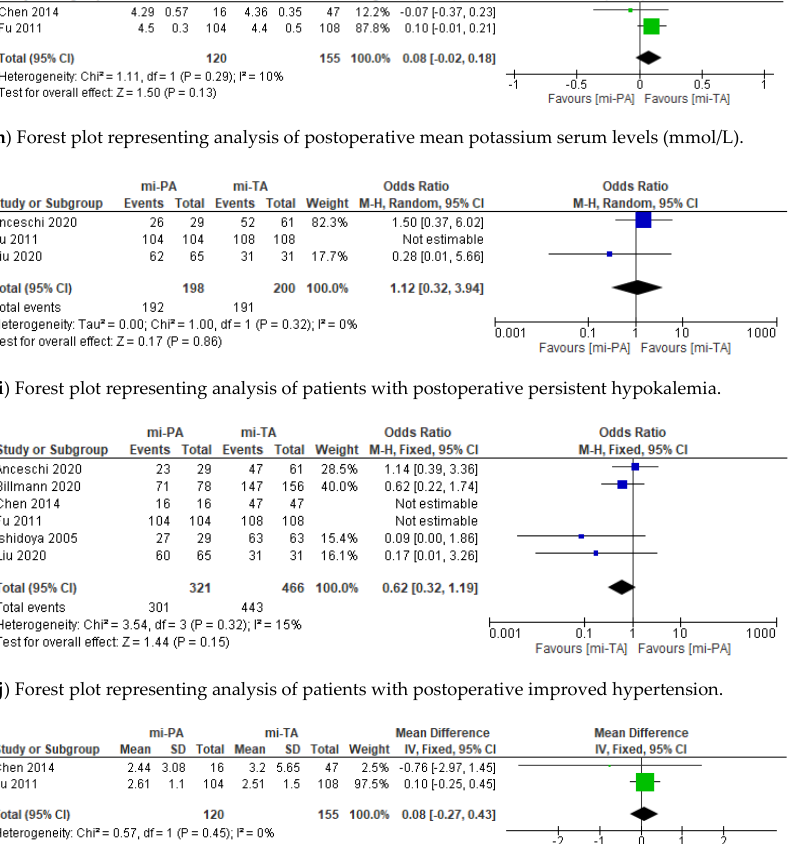
( k ) Forest plot representing analysis of postoperative plasma renin activity (ng/mL/h).